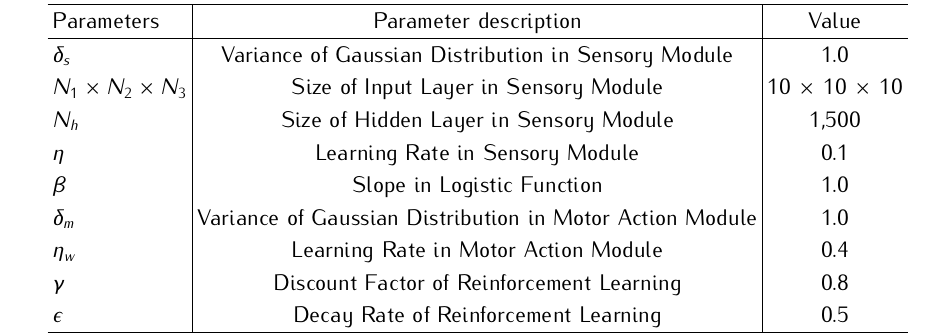
Table 2. Network parameters